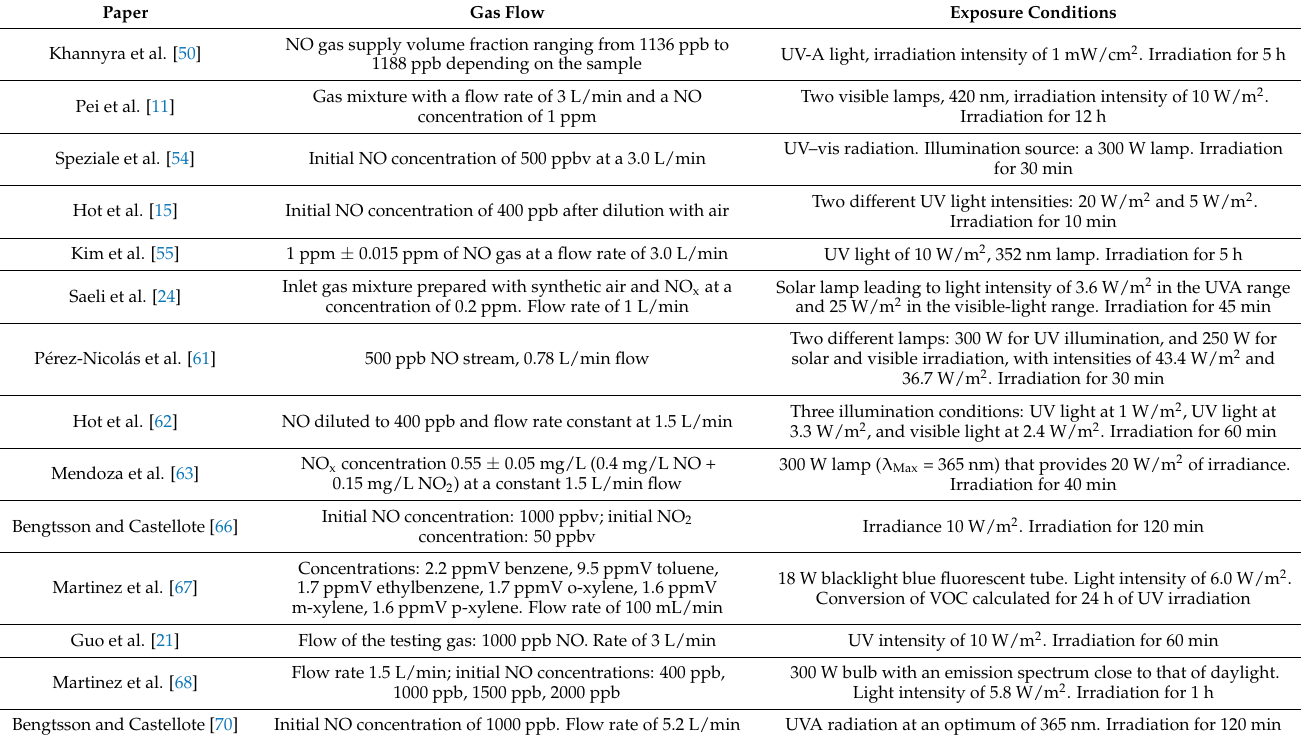
Table 5. Details on the gas flow and exposure conditions used for the depolluting effect assessment by the studied